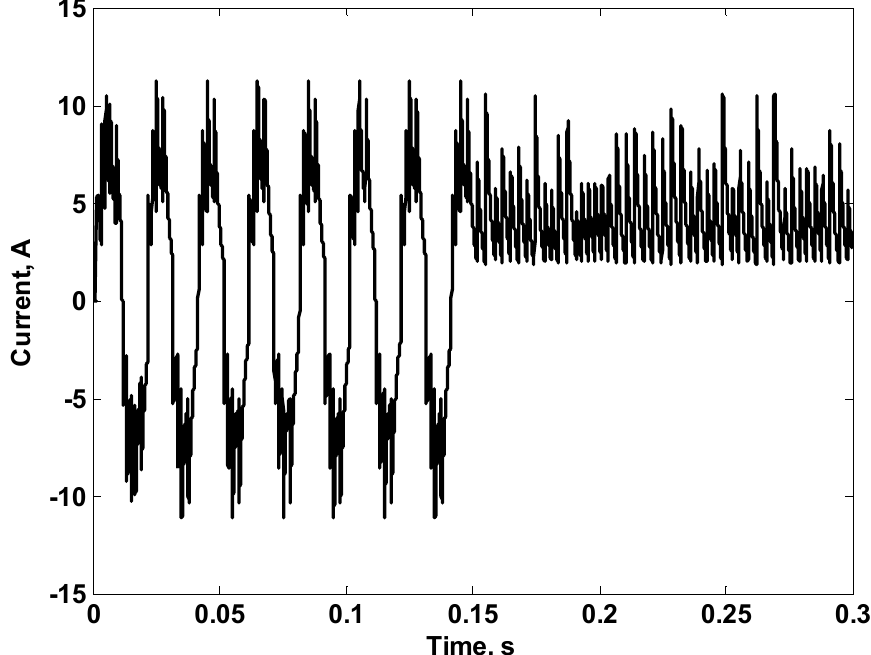
Figure 33. Obtained Current when the Reference Signal is Adjusted at 220 V, 50 Hz with a transfer to a DC signal of 200 V at 0.15 s.